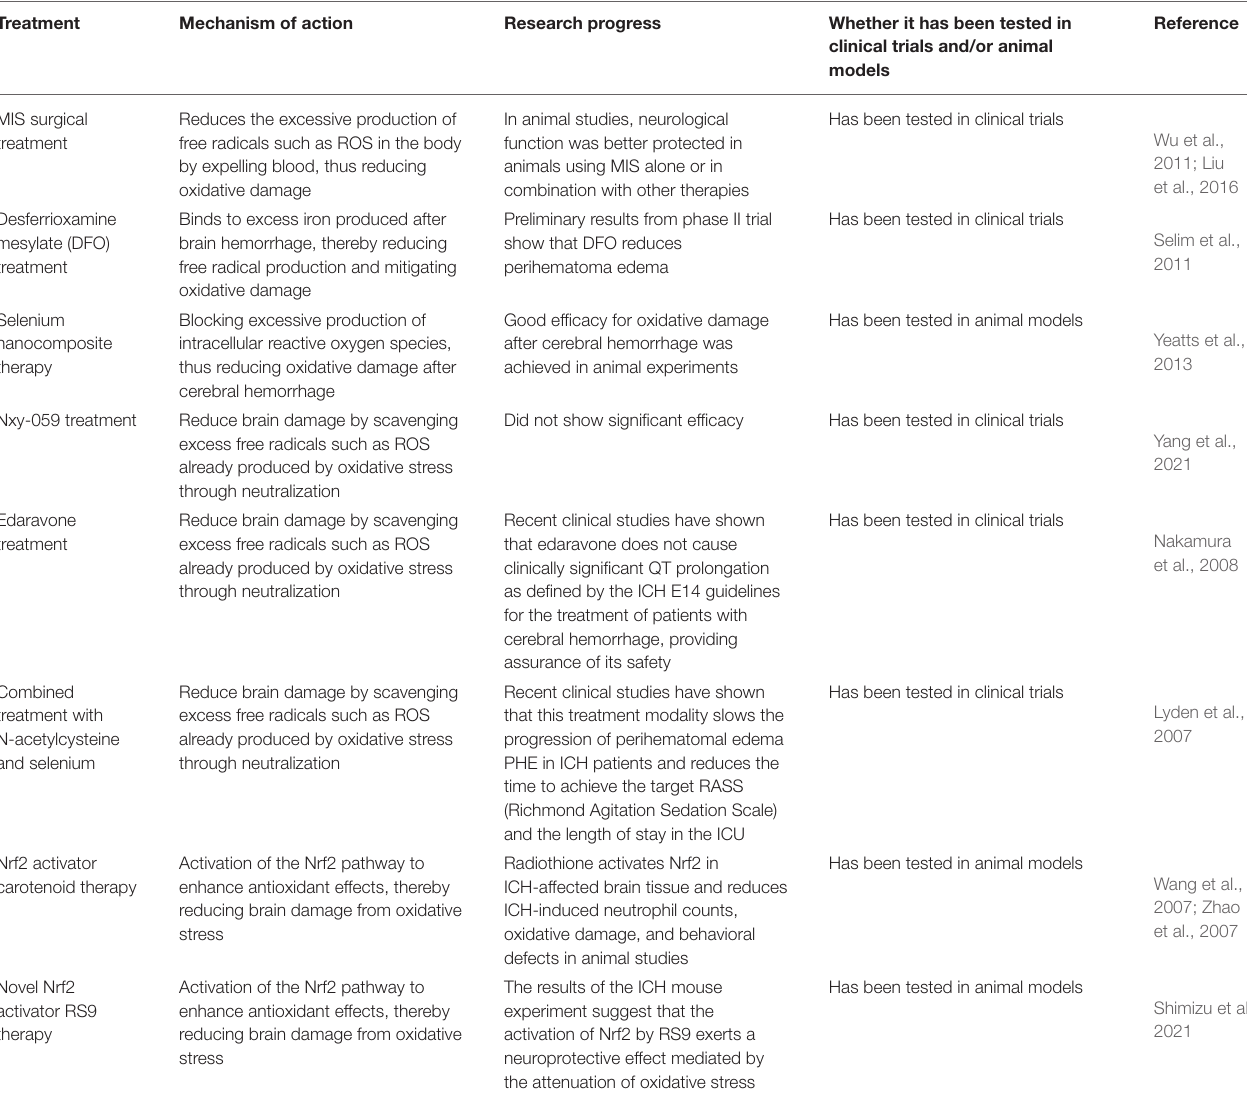
TABLE 1 | Antioxidant therapy for cerebral hemorrhage.